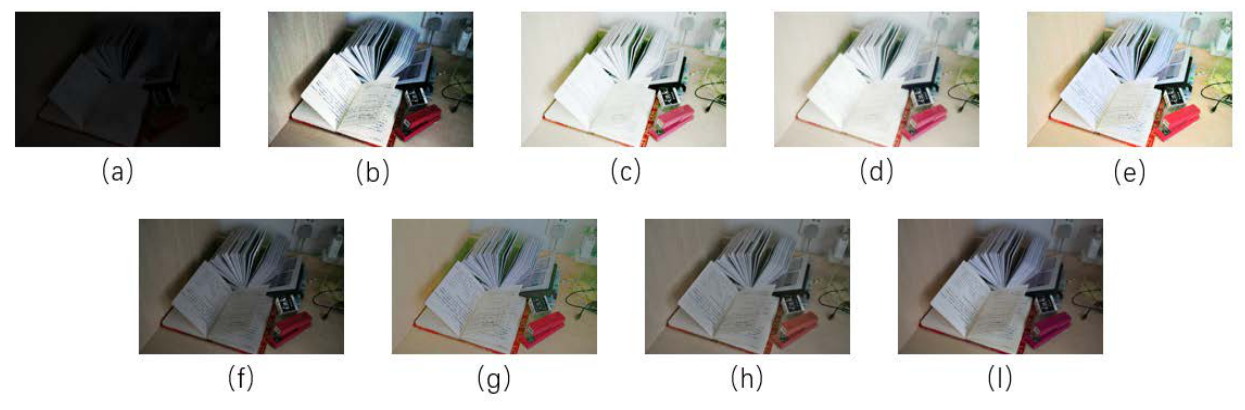
Figure 2. Enhanced effect of low illumination image. ( a ) Low illumination image; ( b ) HE; ( c ) Retinex; ( d ) MSR; ( c ) MSRCP; ( f ) LIME; ( g ) RetinexNet; ( h ) Ours; ( I ) Ground Truth. Table 1. Quantitative comparison of the results of each method. The bold numbers indicate the best performance.